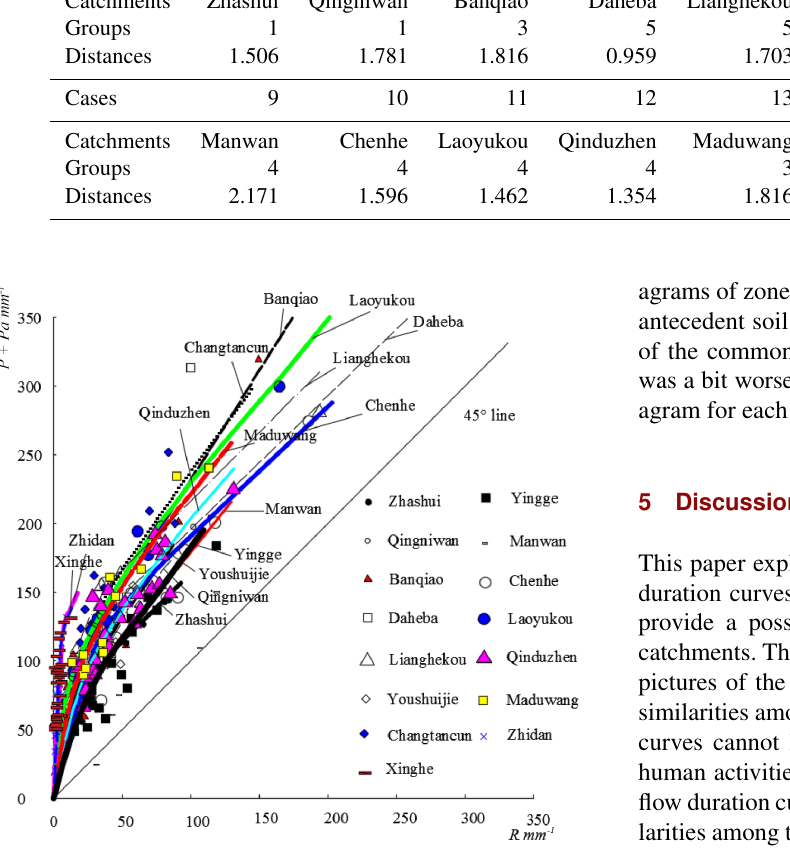
Figure 5. The coaxial correlation diagram for each